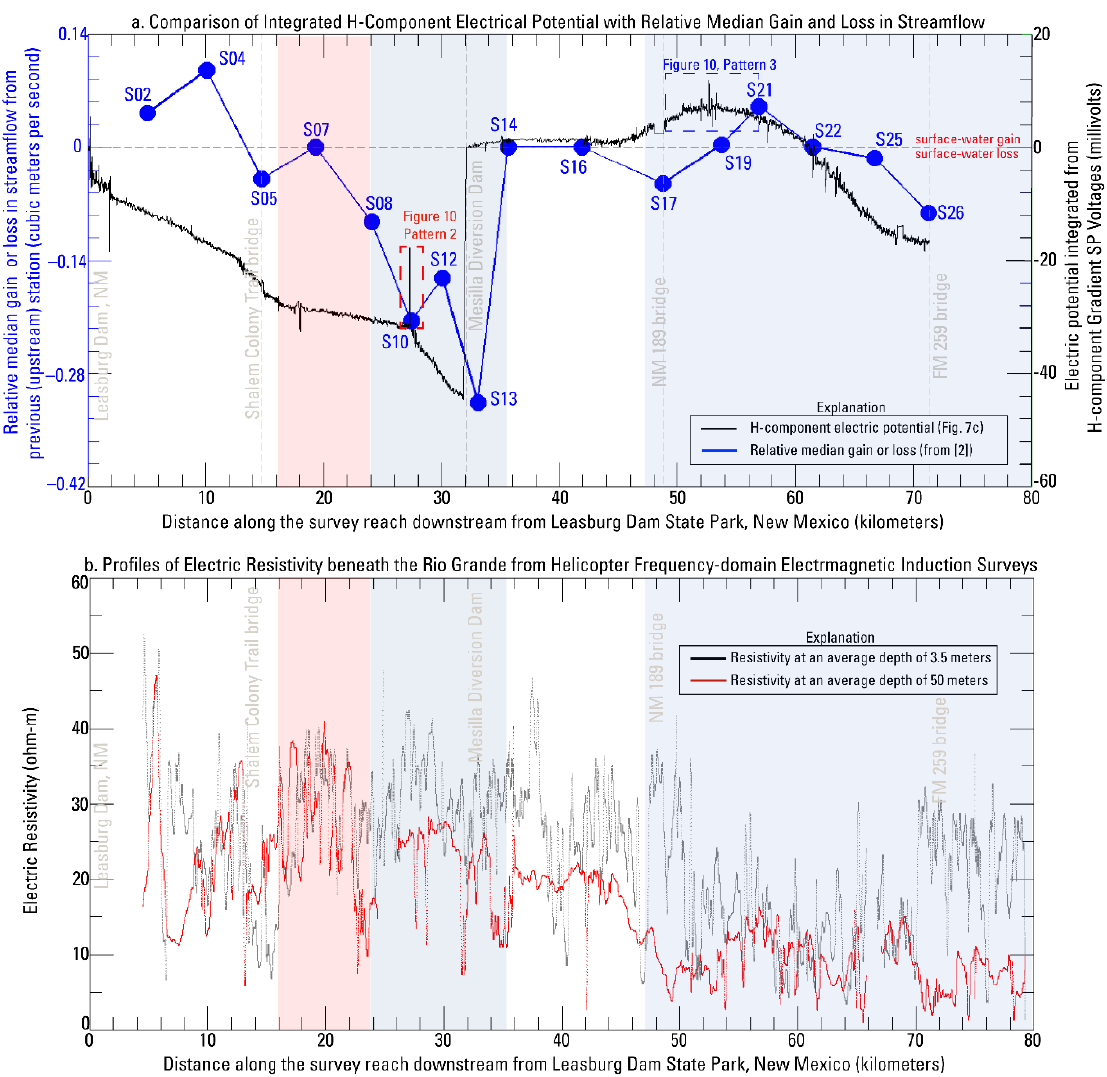
Figure 9. ( a ) Comparison of integrated electric potential (black) integrated from the H component of drift-corrected gradient SP data (see also Figure 2 for locations of seepage-measurement stations) with streamflow data (blue) published by [2,46,61]. Station S02 is relative to station S01 located near 0 km on the horizontal axis (Figure 3). Station S14 is relative to Station S13. Color-shading represents the 2010–2011 water-level differences between the Rio Grande alluvium and the upper part of the Santa Fe Group (Figure 3). Water-level differences greater than 0 m (blue shades) indicate that the hydraulic head in the Rio Grande alluvium is greater than the hydraulic head in the upper part of the Santa Fe Group, whereas differences less than 0 m (red shades) indicate the opposite. ( b ) Comparison of resistivity profiles at average depths of 3.5 m (black) and 50 m (red) beneath the Rio Grande, determined from helicopter frequency-domain electromagnetic surveys.